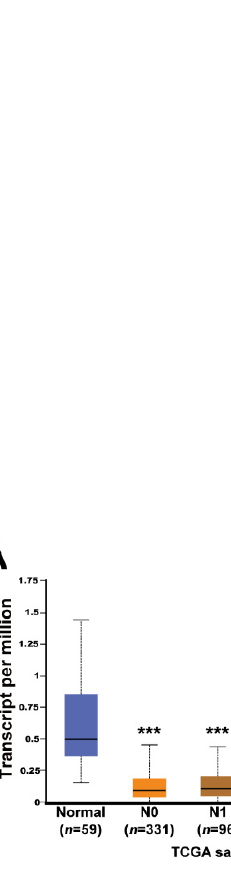
were ten proteins interacting with ADAMTS8 (Figure 6A), including ADAMTS2, ADAMTS10, ADAMTS13, ADAMTS19, ADAMTSL2, THBS1, THBS2, THSD1, ACAN and POFUT2. Among them, eight proteins were excluded based on low correlations with ADAMTS8. Only two proteins, THSD1 and ADAMTSL2, correlated well with ADAMTS8 (Table 2). The correlations of THSD1 and ADAMTSL2 with ADAMTS8 amounted to 0.75 and 0.58, respectively (Figure 6B,C). Low expression of THSD1 existed in the tumor parts, lymph node metastasis and tumor stage compared with the normal parts in lung cancer patients (Figure 6D). Low expression of ADAMTSL2 was presented in the tumor parts but was not related to lymph node metastasis and tumor stage compared with the normal parts (Figure 6E). A poor overall survival time was also found in patients with lower ex- pression of ADAMTSL2 and THSD1 ( F igure 6F,G). The results would explain the protein interactions mediating lung cancer tumorigenesis.